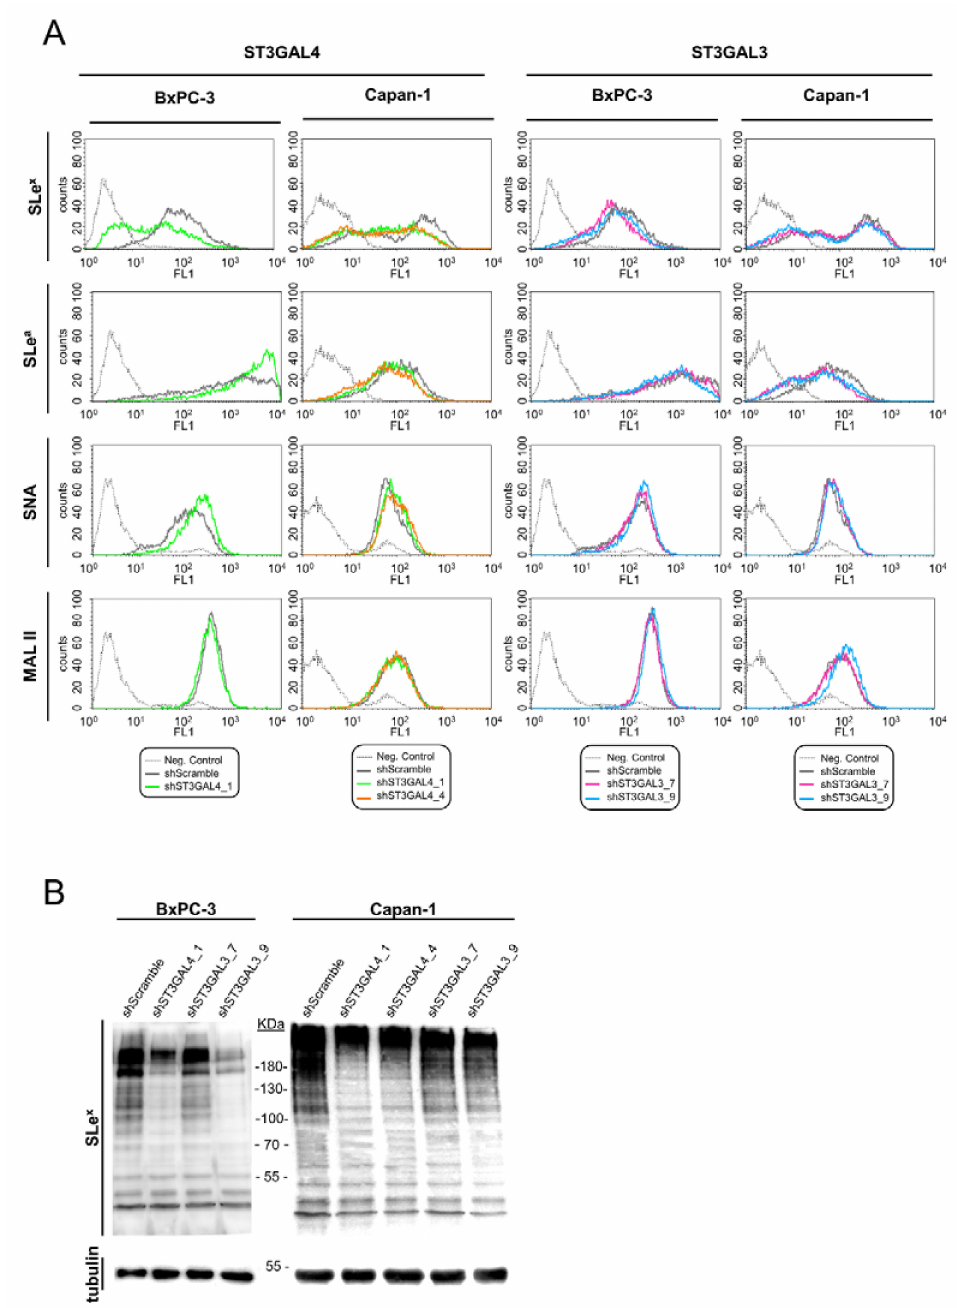
Figure 5. Glycan analysis of ST3GAL3 and ST3GAL4 knockdown BxPC-3 and Capan-1 cells. ( A ) Representative flow cytometry profiles of the cell surface glycans structures detected with sLe x and sLe a antibodies and the lectins SNA and MAL II in knockdown ST3GAL4 cells (left) and ST3GAL3 cells (right) using di ff erent shRNA sequences. Negative controls (without the primary antibodies or lectins) are represented using a continuous black dot line: ( ... ), shScramble (black line), shST3GAL4_1 (green line), shST3GAL4_4 (orange line), shST3GAL3_7 (pink line) and shST3GAL3_9 (blue line). ( B ) Immunodetection by WB showing the reduction of sLe x antigens in selected cell lysates from total protein on BxPC-3 (top left) and Capan-1 cells (top right) with anti-sLe x antibody (clone CSLEX1). Anti-tubulin WB of the corresponding membrane is showed on the bottom